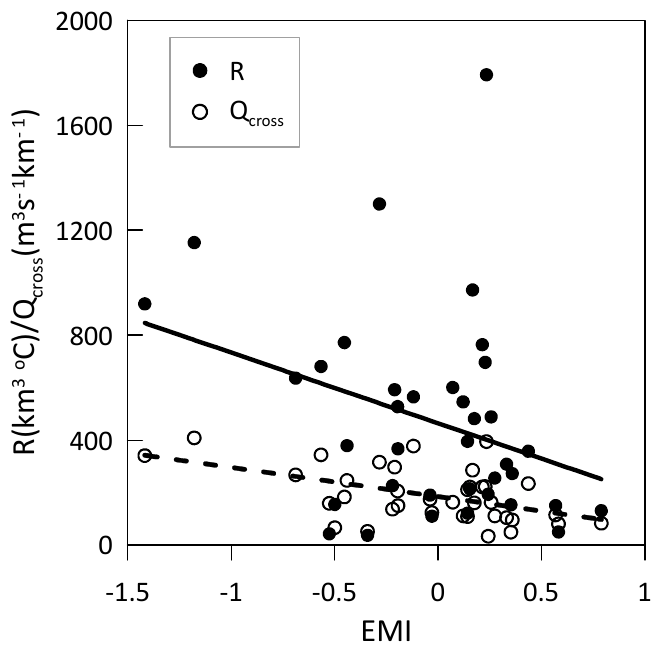
Figure 7. Relationship between upwelling intensity ( R ), Q cross , and EMI for the coastal upwelling system of the Taiwan Strait.